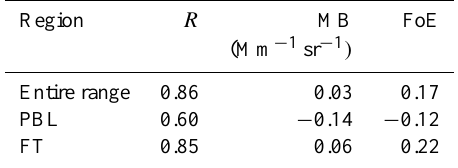
Table 2. Statistics of CALIOP and EARLINET agreement within the PBL and the FT with ground track distance within 100km.